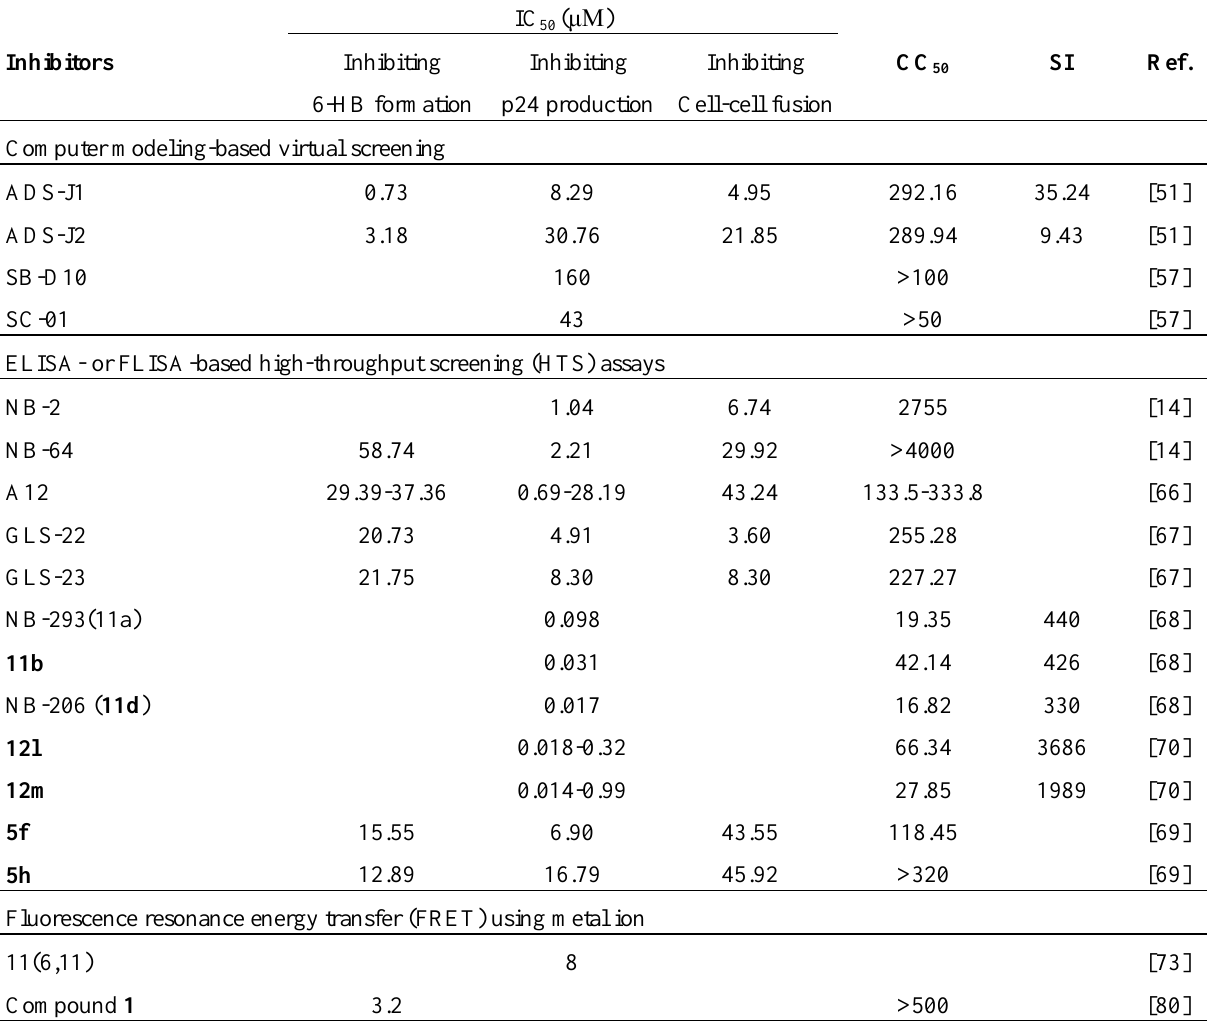
Table 1. The properties of the small molecule HIV-1 fusion inhibitors targeting gp41